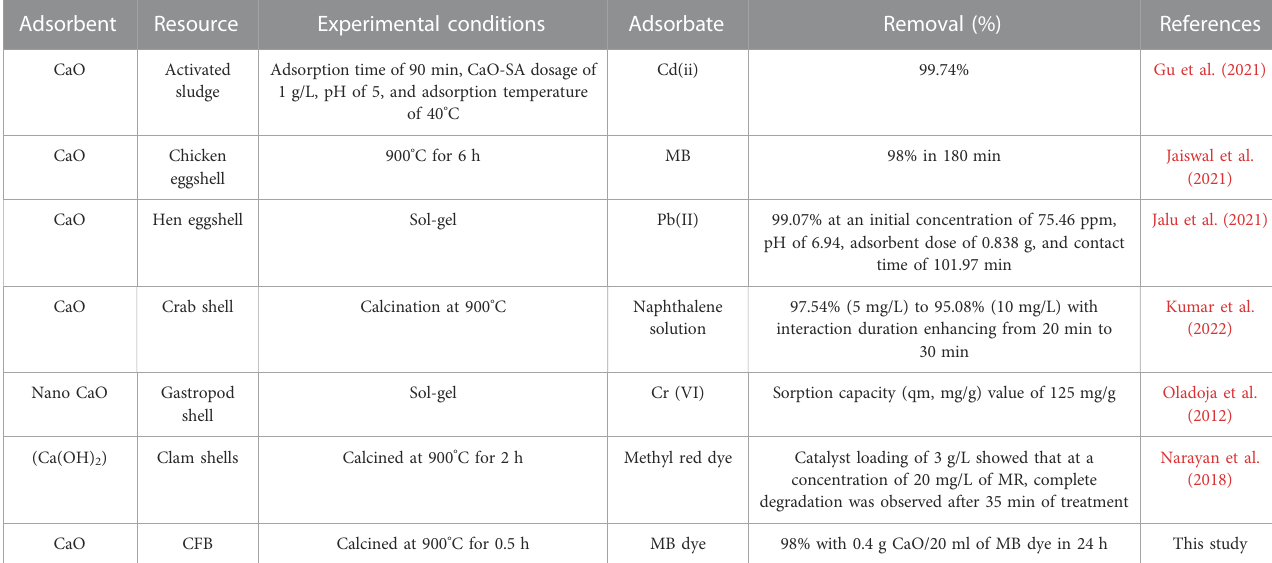
TABLE 2 Comparison of different CaO-based adsorbents and their removal ef fi ciency.